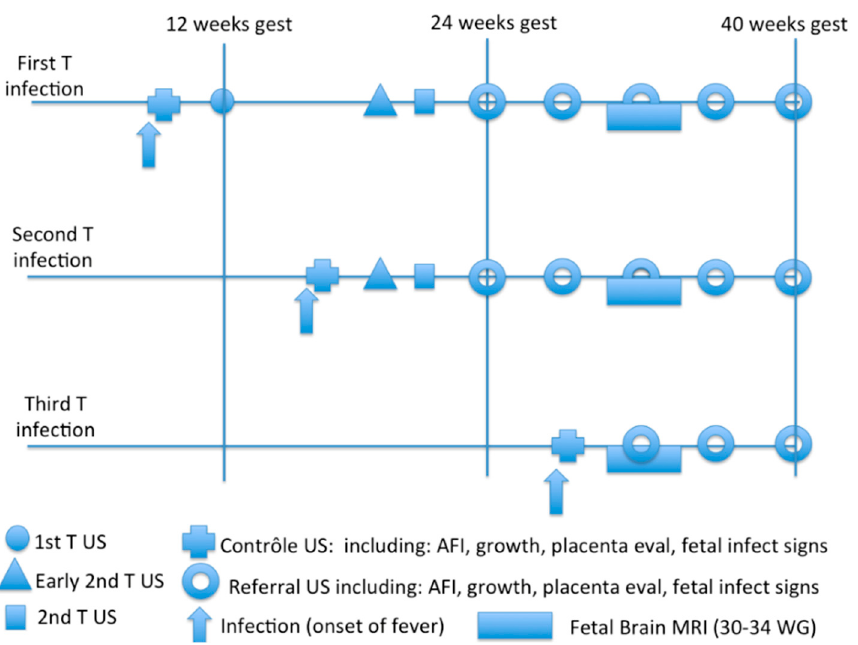
Figure 3. Proposed follow-up in the case of MXPV infection during pregnancy. For second- and third-trimester infections, the follow-up should be the same as that of the first-trimester infection, with a referral ultrasound performed monthly. According